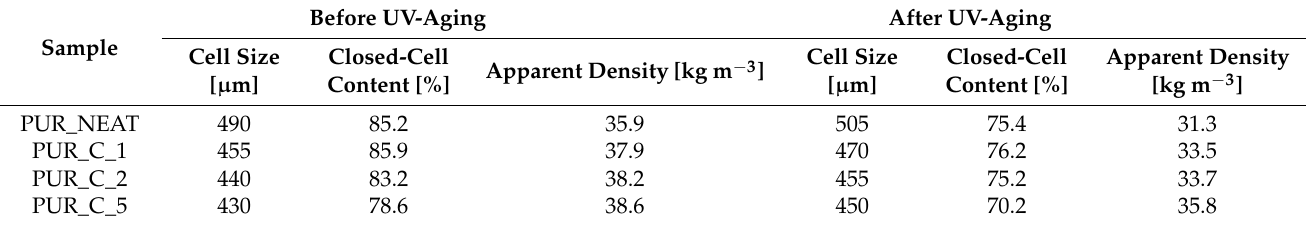
Table 3. Cell size, closed-cell content, and apparent density of PUR composites before and after UV-aging.